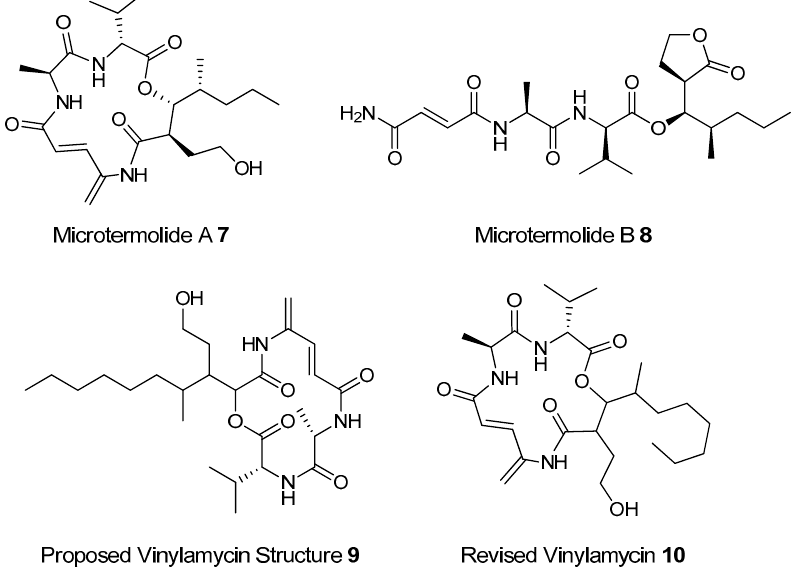
Figure 8. Microtermolides, produced by termite-associated microbes, and the originally proposed and revised structure of the related NRP vinylamycin.